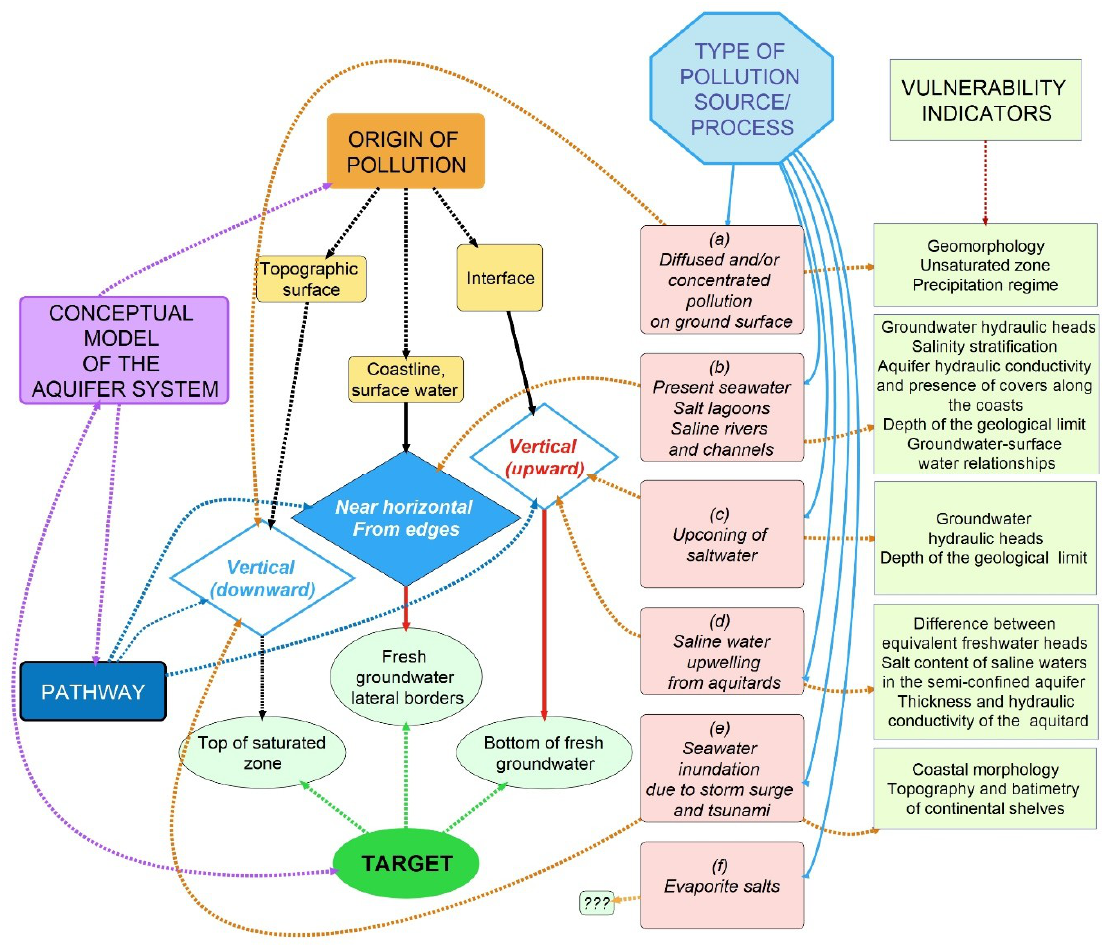
Figure 2. Scheme of the elements forming the 3D vulnerability of a coastal aquifer; relationships among origin, pathways and pollution sources, type of pollution source/process, and vulnerability